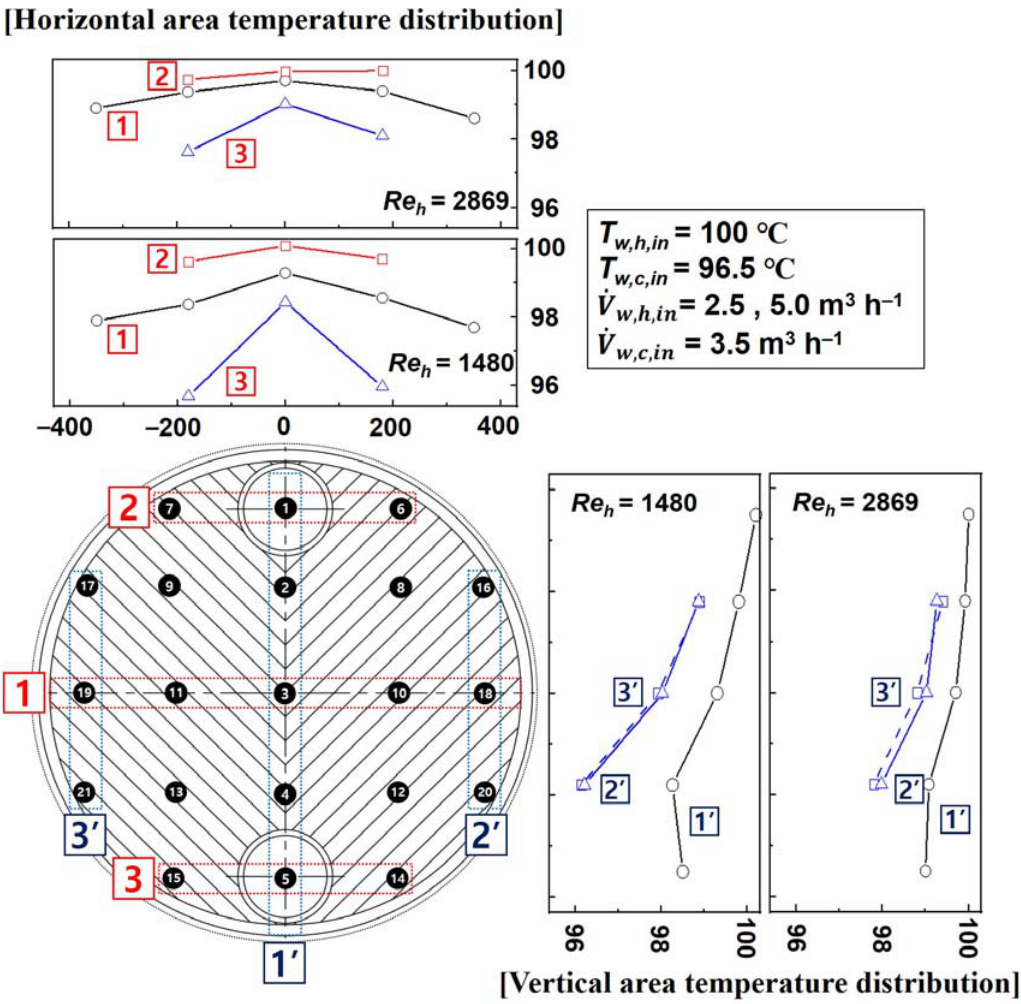
Figure 15. The horizontal and vertical temperature profiles with respect to the Re. Figure 16 shows the horizontal and vertical temperature profiles at the center and edge of the plate with respect to the heat flux. In the horizontal direction, the temperature difference between the edge and bottom of the plate increased as the heat flux increased, owing to the increased heat transfer rate. In the vertical direction, as the heat flux increased, the temperature on the plate gradually decreased owing to the heat exchange in the center of the plate.